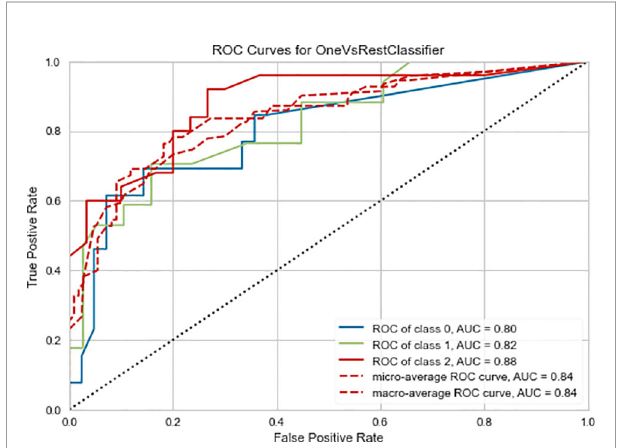
FIGURE 4 | Three-class (one-vs-rest) Receiver operating characteristic (ROC) diagram of the external validation cohort of the radiomics prediction model. Class 0 is the very low- and low-risk group, class 1 is the intermediate-risk group, and class 2 is the high-risk group. The two dashed lines respectively show the ROC curves of micro-average and macro-average, indicating the overall distinguishing ability of the three-class classi fi cation.